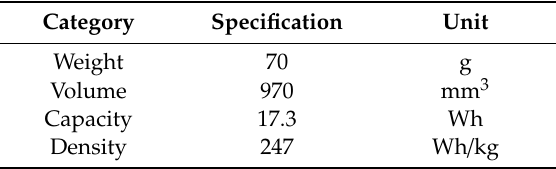
Table 7. Form factor of Vahana.